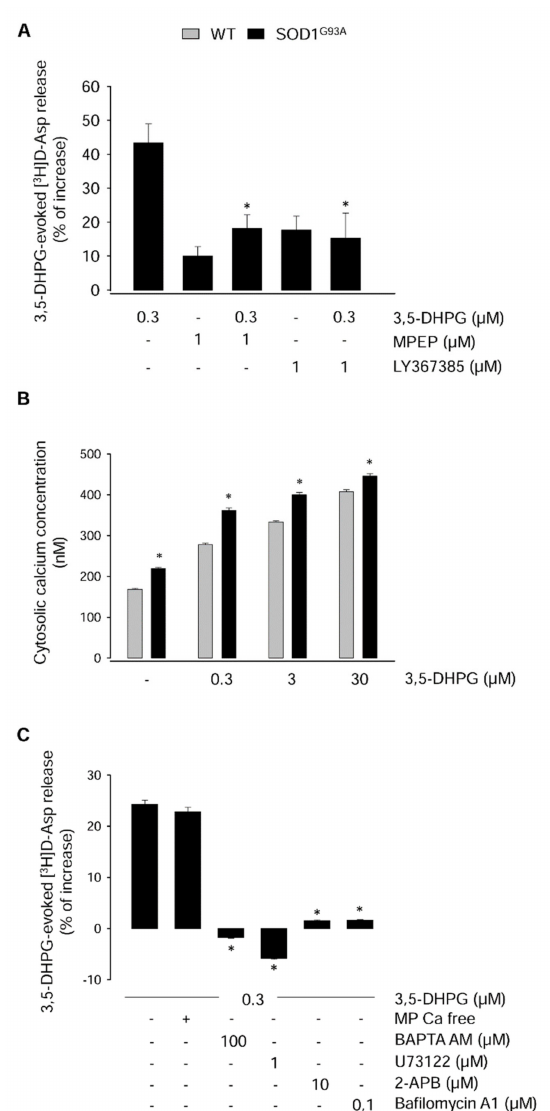
Figure 2. Mechanisms underlying the 3,5-DHPG-evoked [ 3 H] d -Asp release in spinal cord synaptosomes from 90-day-old WT and SOD1 G93A mice. ( A ) The e ff ects of mGluR1 and mGluR5 selective antagonists were tested on the 0.3 µ M 3,5-DHPG-evoked [ 3 H] d -Asp release. Spinal cord synaptosomes were exposed in superfusion to 1 µ M LY367385 or MPEP, 8 min before and concomitantly with 0.3 µ M 3,5-DHPG. See the legend of Figure 1 for other technical details. The data reported are the means ± SEM of five independent experiments (five WT and five SOD1 G93A mice) run in triplicate (three superfusion chambers for each experimental condition). * p < 0.05 vs. 3,5-DHPG (one-way ANOVA followed by Bonferroni’s post-hoc test). ( B ) Resting and 3,5-DHPG-evoked [Ca 2 + ] C were measured in spinal cord synaptosomes purified from 90-day-old SOD1 G93A and age-matched WT control mice. Synaptosomes were labelled with fura-2-acetoxymethyl ester (fura 2-AM) and exposed to standard medium or to 0.3, 3, and 30 µ M 3,5-DHPG. [Ca 2 + ] C was determined fluorometrically as described in the Methods section. Data are means ± SEM of three independent experiments (three WT and three SOD1 G93A mice) run in triplicate (three experimental replicates). * p < 0.001 vs. WT mice (two-way ANOVA followed by Bonferroni’s post-hoc test). ( C ) The e ff ects of external calcium absence (Ca-free medium), cytosolic calcium chelation by 1,2-bis(2-aminophenoxy)ethane- N , N , N (cid:48) , N (cid:48) -tetraacetic acid tetrakis acetoxymethyl ester (BAPTA-AM) (100 µ M), phospholipase C inhibition by 1-[6-[((17 β )-3-methoxyestra-1,3,5[10]-trien-17-yl)amino]hexyl]-1H-pyrrole-2,5-dione (U73122) (1 µ